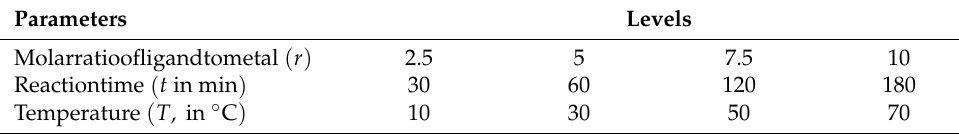
Table 4. Parameters and levers of the OFAT experiments.